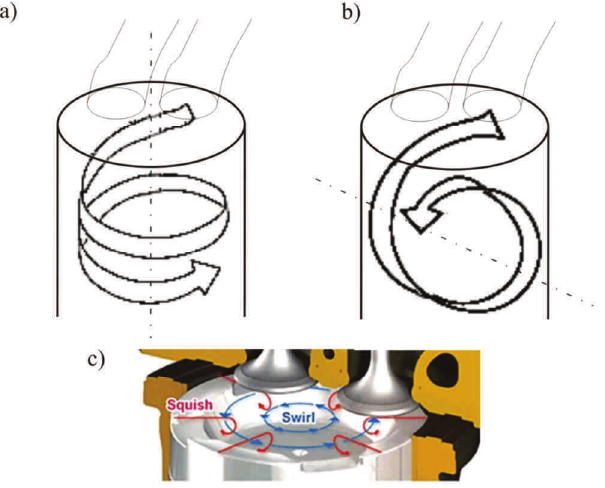
Fig. 1. Types of in-cylinder flow motion: a) swirl, b) tumble, c) squish and swirl